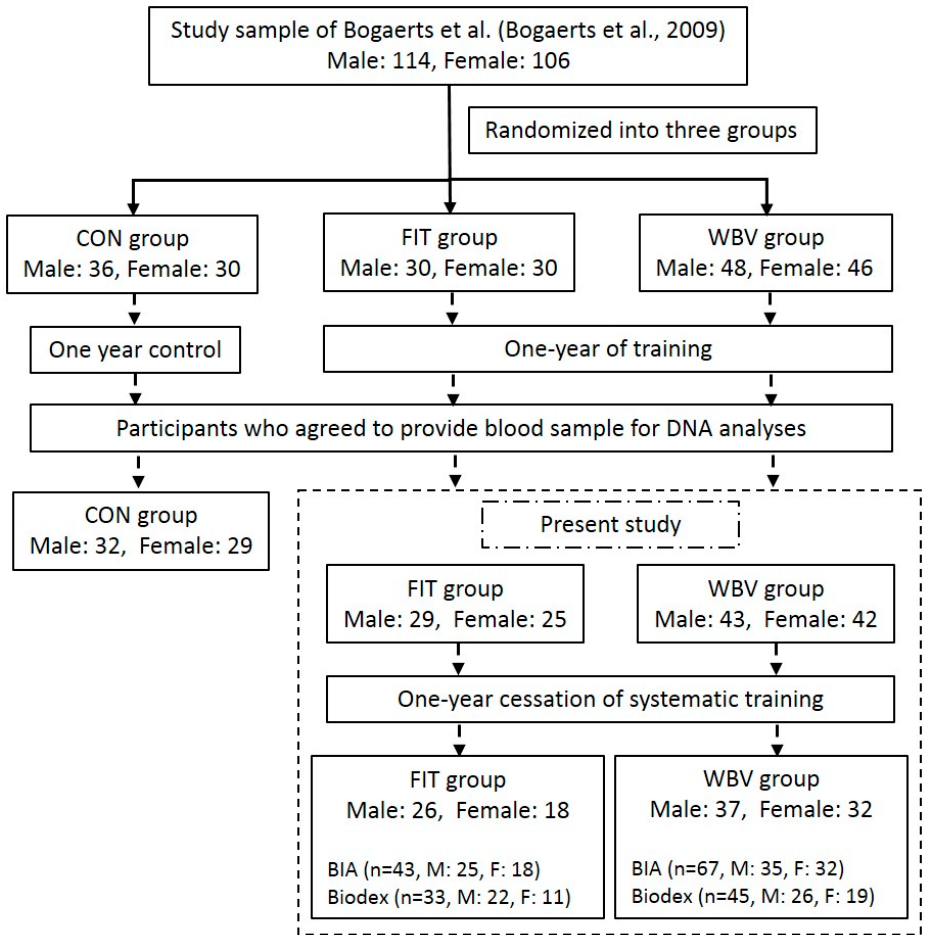
Figure 1. Flowchart of participants in present study. CON: control; FIT: combined fitness; WBV: whole-body vibration; BIA: bioelectrical impedance analysis.